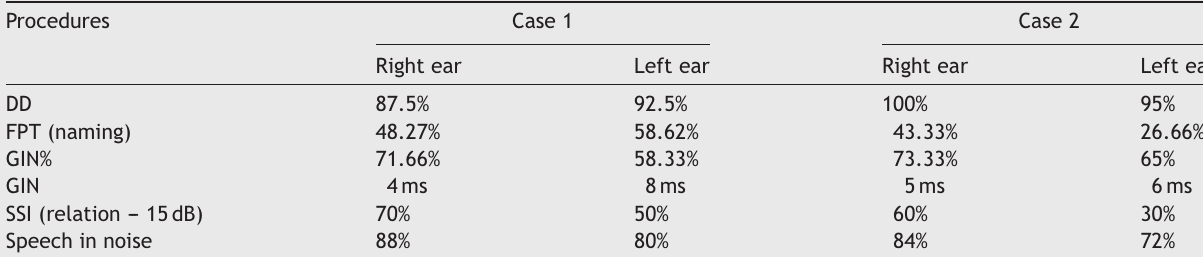
Assessment values of auditory processing.